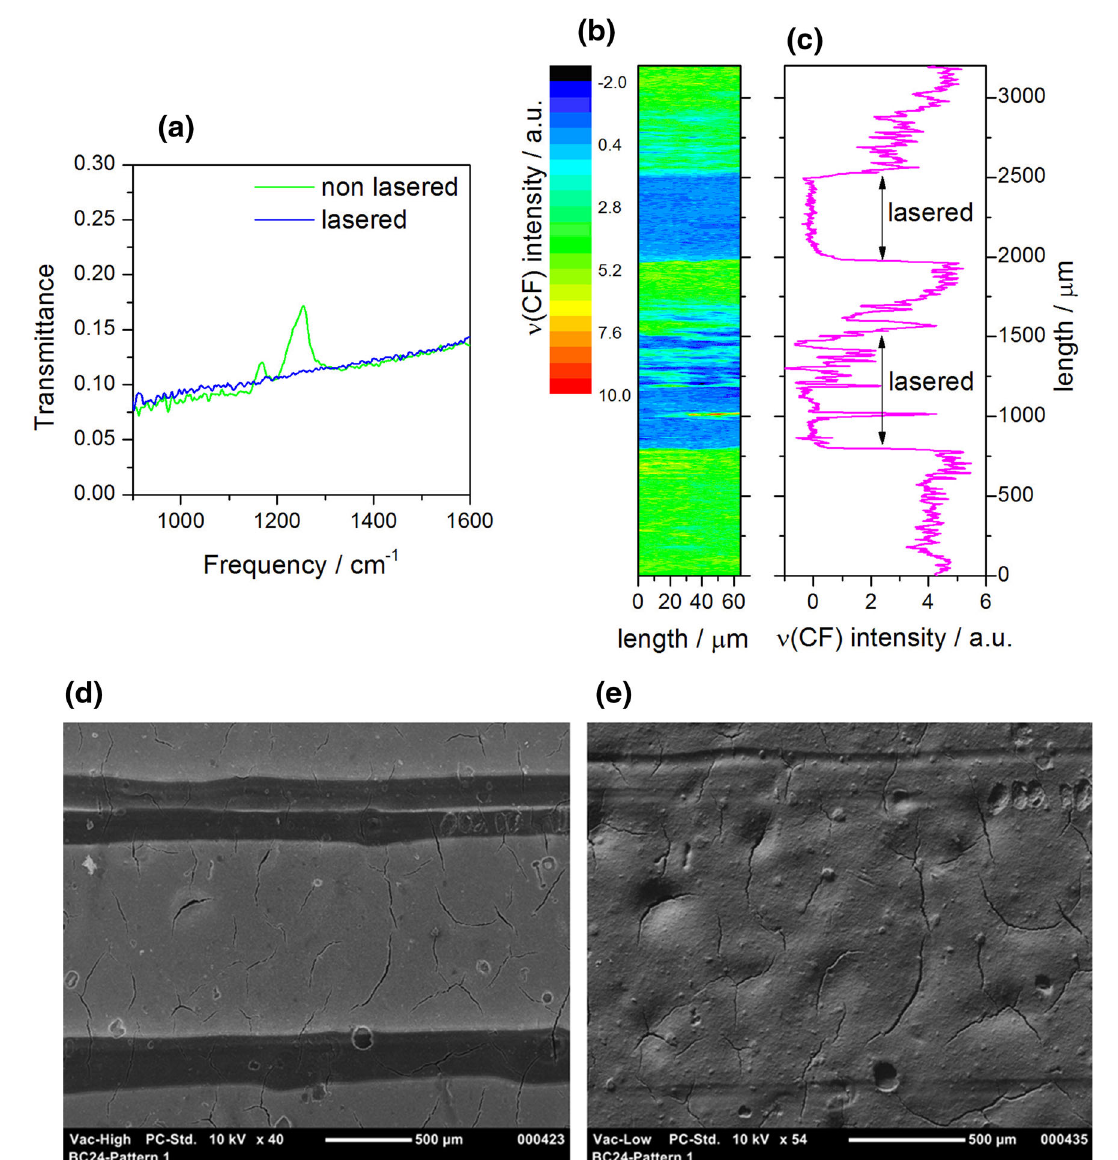
Fig. 2 a FTIR spectra of the C–F stretch of laser burned and pristine MPLs. b FTIR image of the MPL locally treated with laser radiation. The color scale corresponds to integrated C–F intensities. c FTIR line